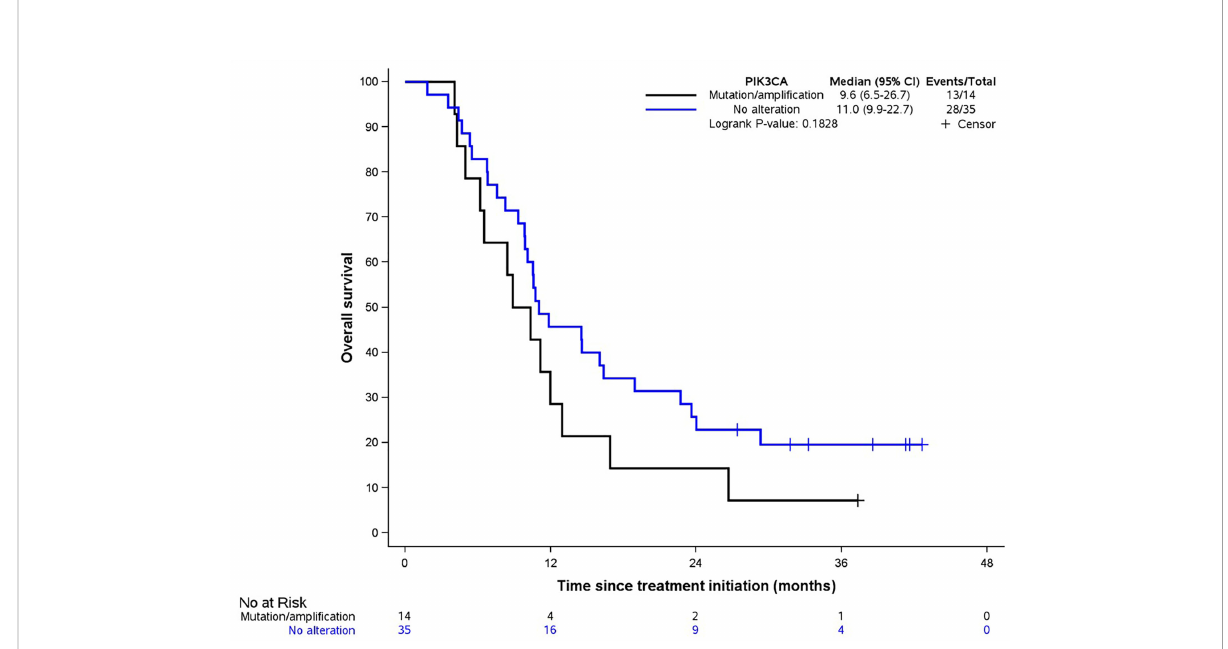
FIGURE 4 OS in presence of PIK3CA alteration. Blue line symbolizes no alteration, black line symbolizes the presence of a mutation and/or ampli fi